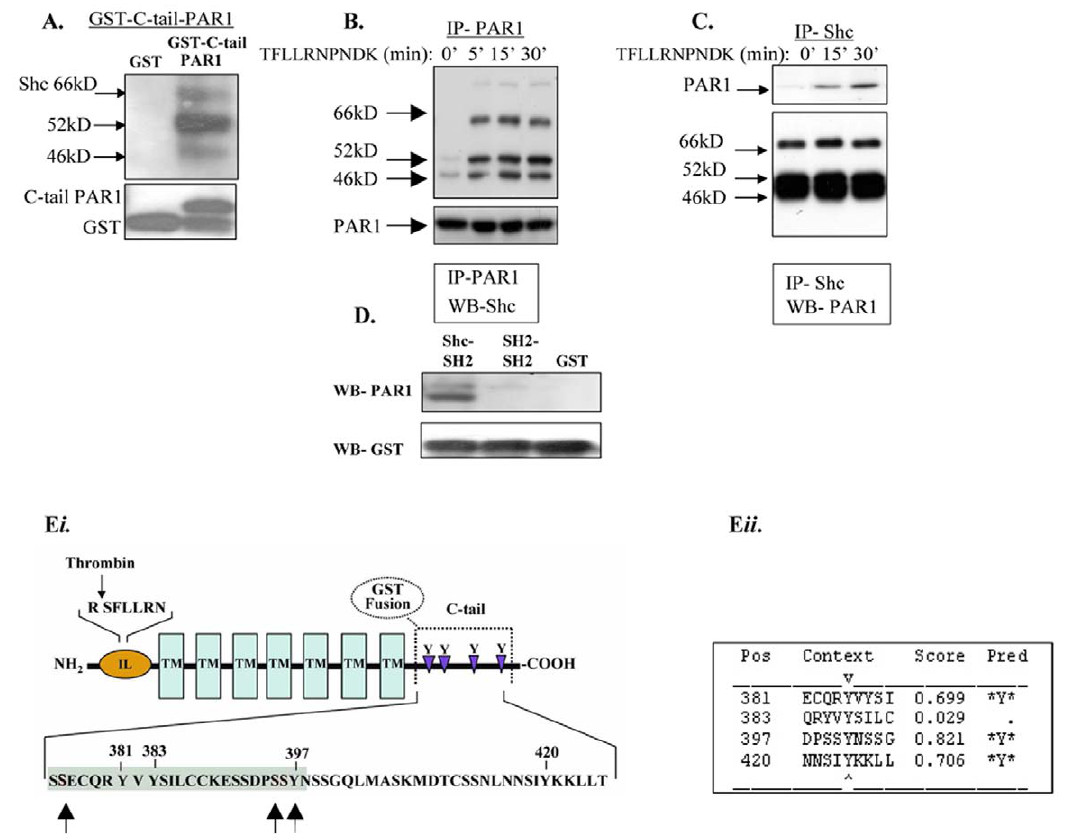
Figure 3. PAR 1 C-tail recruits Shc adaptor protein. A. PAR 1 GST-C-tail binds Shc adaptor. MDA-MB-435 cell lysates were applied to a GST- PAR 1 C-tail or GST control column. After an adequate binding period of the designated cell lysates to the columns, a washing step was performed. This step was performed in order to wash out all non-specific proteins, leaving the GST- PAR 1 -C-tail column firmly bound to targeted cell lysate proteins. Next, specifically-bound proteins were eluted via the addition of gel ‘‘sample buffer’’ and detected by western blot analysis using anti-Shc antibodies. B and C . Co-immunoprecipitation analyses of PAR 1 and Shc. Lysates of non-activated or TFLLRNPNDK-activated MDA-MB-435 cells were co- immunoprecipitated with either anti- PAR 1 (B) or anti-Shc (C) antibodies. D . PAR 1 binds to Shc-SH2 domain. MDA-MB-435 cell lysates were loaded onto columns of GST-Shc-SH2, GST linked to a tandem SH2 from a non-relevant protein, or GST alone. Specifically-bound proteins were eluted and detected with anti- PAR 1 antibodies. E i . Schematic representation of PAR 1 -C-tail . The scheme illustrates PAR 1 structure. IL - internal ligand, TM - transmembrane. Important tyrosine (Y) residues are indicated and the conserved sequence is gray. Serine residues in the C-tail region that may be involved in PAR 1 -Shc association are indicated in red. E ii . Analysis of PAR 1 C-tail Y-residues by NetPhos 2.0 server . Y 381 , Y 397 and Y 420 were scored highly likely to undergo phosphorylation, as shown in the table. ‘‘Pred’’ means ‘‘prediction’’ for the predicted score of each of the Y tyrosine residues that is relevant to phosphorylation.